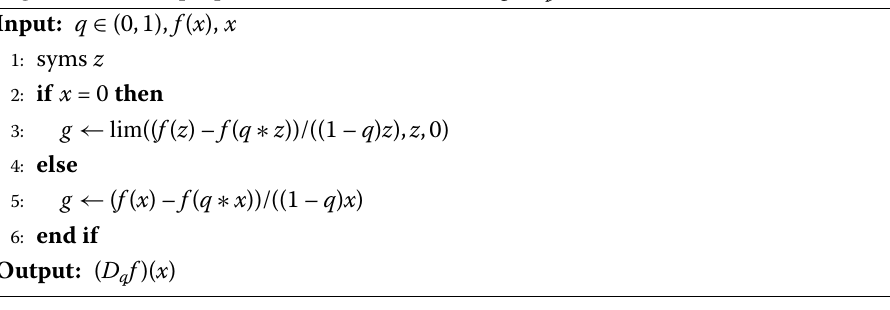
Algorithm 4 The proposed method for calculating ( I α